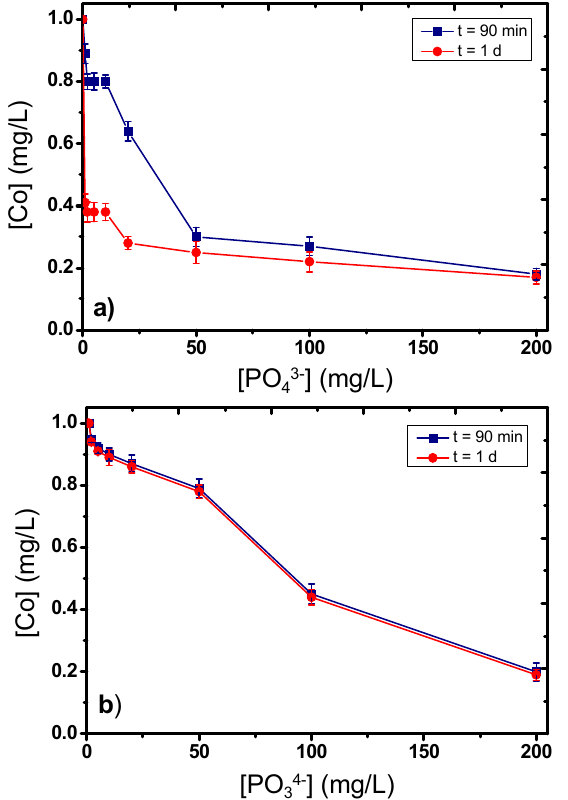
Figure 6. Concentration of soluble cobalt, according to phosphates’ addition during ( a ) O 3 oxidation, and ( b ) O 3 absence. Experimental conditions: ozone concentration 2 mg/L (when applied), catalyst concentration 1 mg/L, pH 7.8, temperature 23 ± 2 °C.